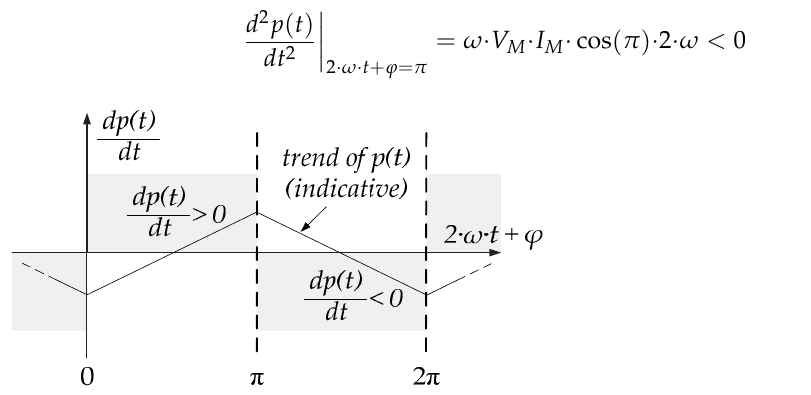
Figure A1. Trend of instantaneous power and its time derivative in Equations (A2) and (A3).